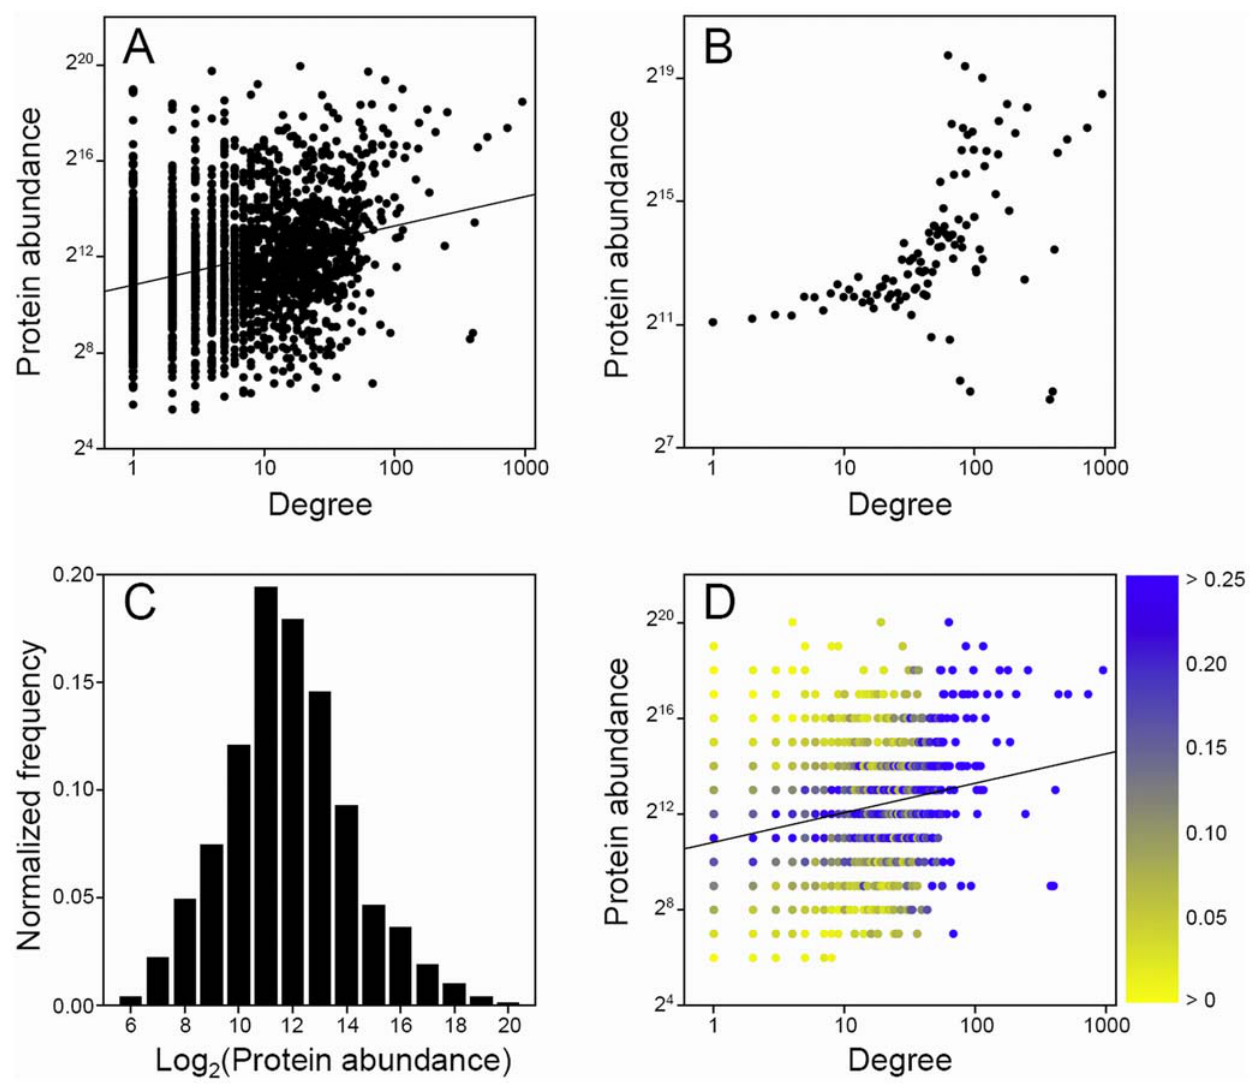
Figure 1. Relationship between protein degree and abundance in the raw yeast TAP Gavin PPI network [ 5 ] using the western blot abundance measurements of Ghaemmaghami et al. [42]. (A) All data points, i.e., each protein’s degree and abundance is plotted; (B) averaged data where log 2 (abundance) values were averaged over proteins having the same degree; (C) total normalized abundance distribution, binned in integer values of log 2 (abundance), for proteins appearing in both PPI and abundance measurement data sets; (D) normalized abundance distributions for each degree where frequencies are shown by color: most yellow signifies smallest nonzero value and most blue represents values larger than 0.25. Best-fit line to data in (A) also shown in (D). Gavin PPI network using the WB abundance measurements [42], and Figure 1B shows the general trend where log 2 (abundance) values were averaged over proteins having the same degree. The Pearson correlation coefficient for this latter averaged data is 0.52 and the corresponding P -value is less than 0.0001. Similar plots are obtained for the other raw yeast TAP PPI data sets and also when using the FC (protein) and GE (mRNA) abundance measurements.